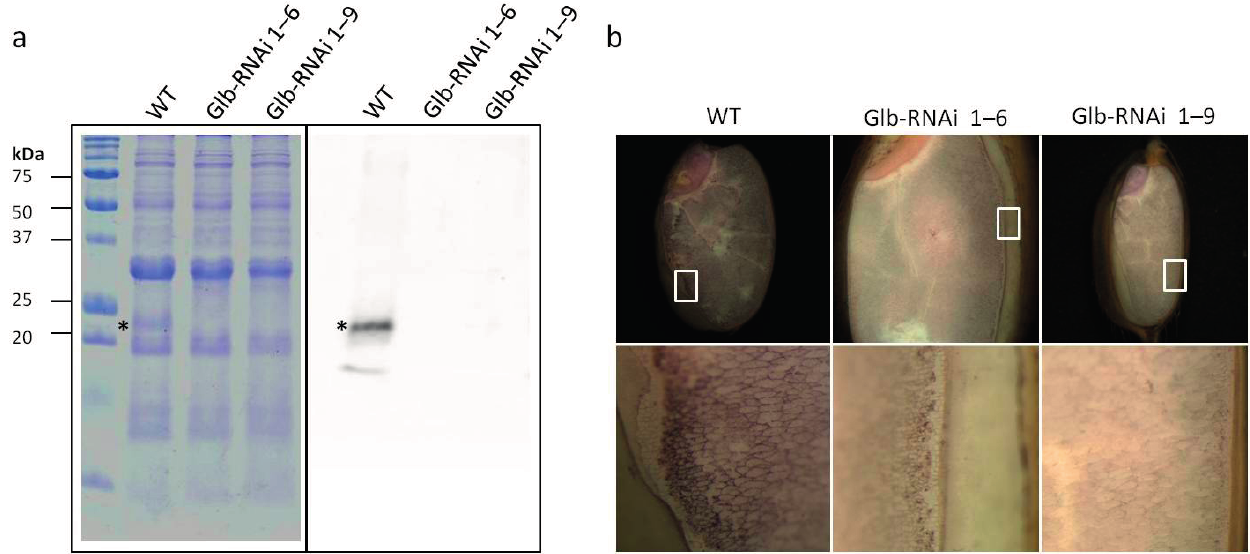
Figure 1. Expression analysis of the globulin gene product in RNAi-mediated transformant seed. ( a ) Western blotting analysis of the total proteins isolated from a single rice grain from wild type (WT) and transgenic lines (Glb-RNAi 1–6 and 1–9). The asterisk indicates the protein recognized by the anti-globulin antibody; ( b ) In situ western hybridization was performed to detect the globulin protein in intact seeds. Sections of mature seeds obtained from WT and transgenic lines (Glb-RNAi 1–6 and 1–9) were treated with anti-globulin antibody and visualized under a microscope. The upper panels show images of the entire section of the stained seed, and the areas marked with a white box are magnified in the lower